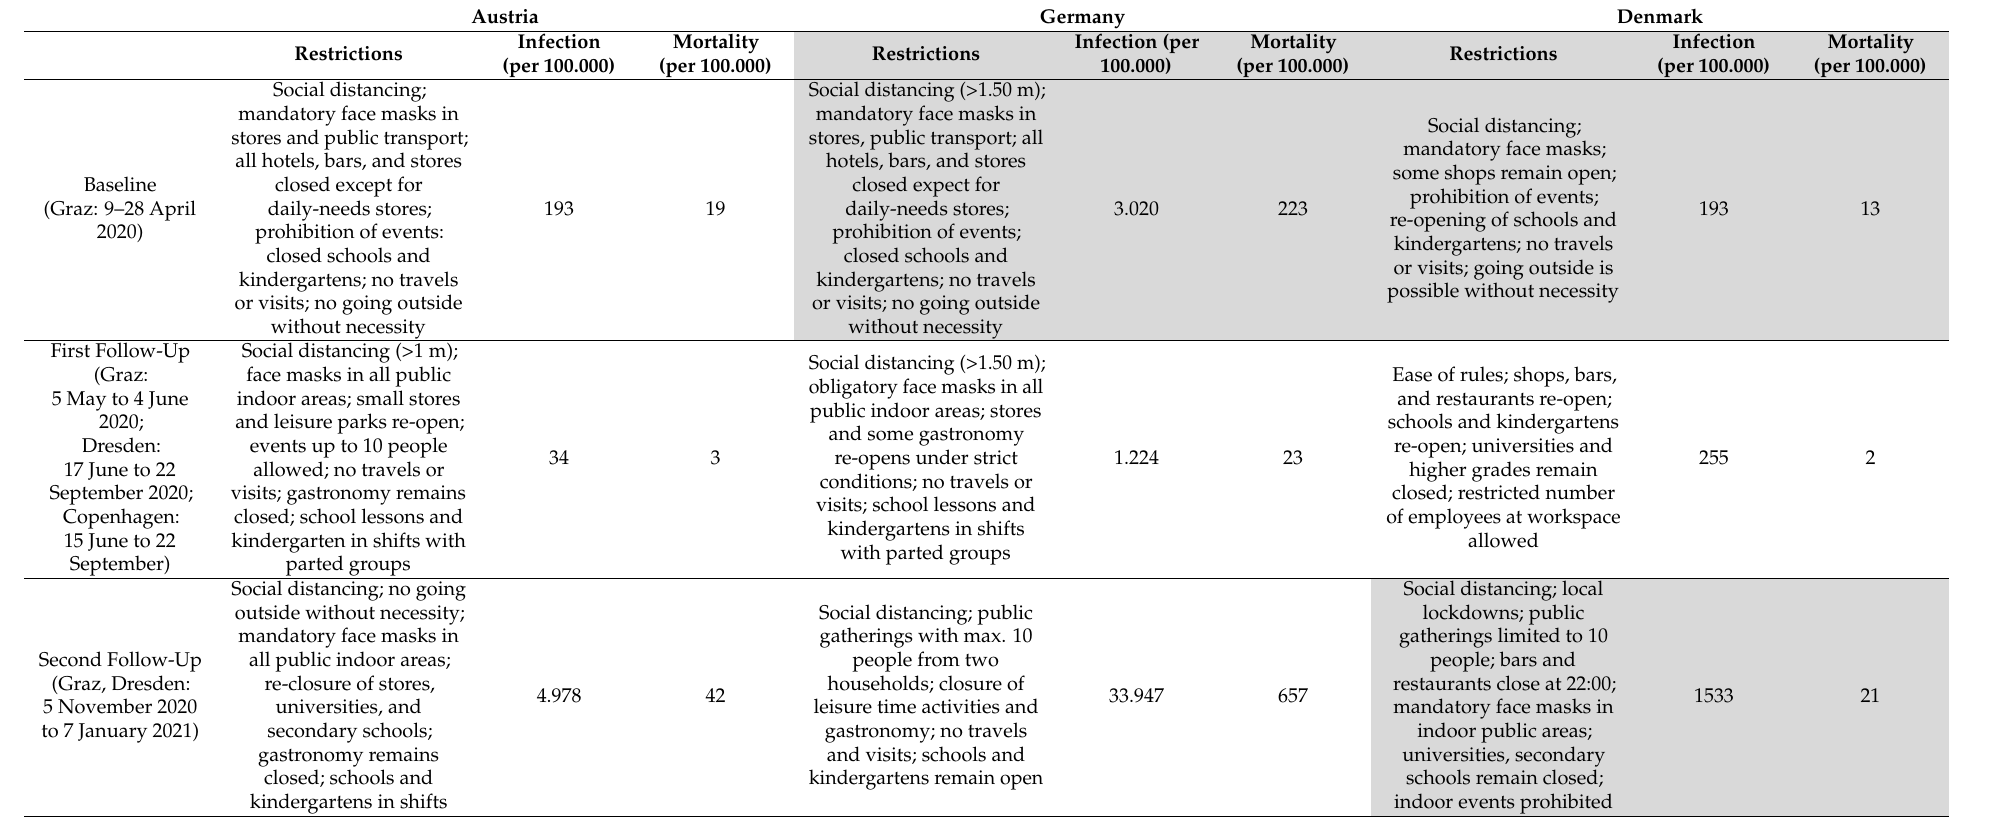
Table 1. COVID-19-related restrictions, infection, and mortality rates for each measurement period in Austria, Germany, and